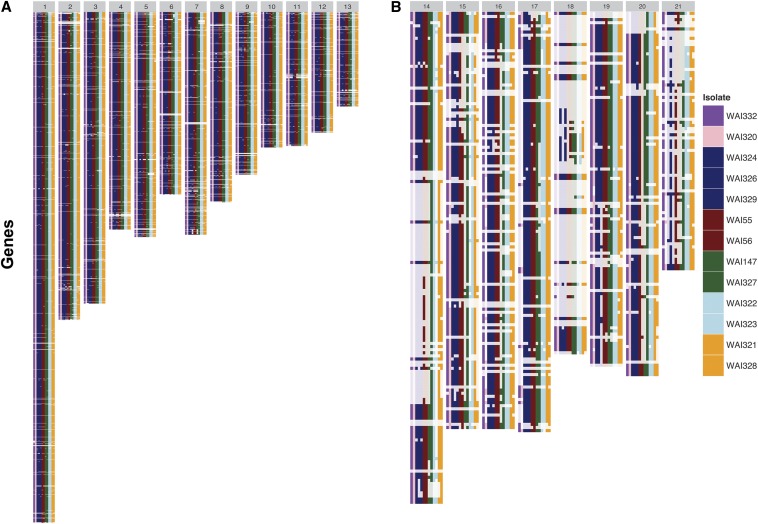
Summary of the presence or absence of IPO323 genes across all chromosomes. Gene presence (dark colors) or absence (translucent) for each re-sequenced isolate is shown for all annotated genes from the reference isolate IPO323. Each row in the figure represents one annotated gene, while each column represents one isolate. There are 13 columns in each panel; the number at the top (in the gray bar) indicates the chromosome. Isolates are ordered from left to right, from earliest to latest year of sampling. Isolates in the same color were sampled during the same year. (A) The core chromosomes of Z. tritici possess most of their annotated genes with very few large deletions. (B) The accessory chromosomes possess several large segmental gene deletions, many of which indicate that entire chromosomes are missing or significantly altered in structure from the reference genome.